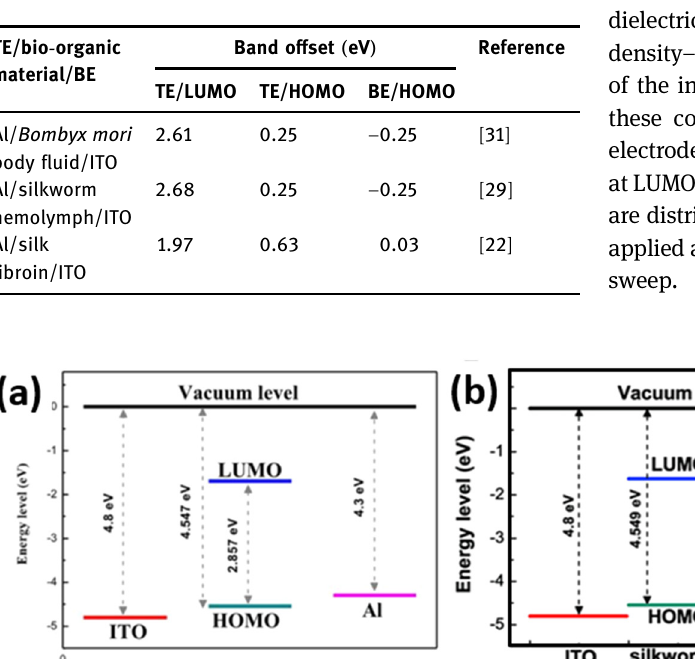
Table 6: Band o ff set values of the top and bottom electrodes ( TE and BE ) with respect to bio - organic materials calculated based on the data obtained from Figure 8